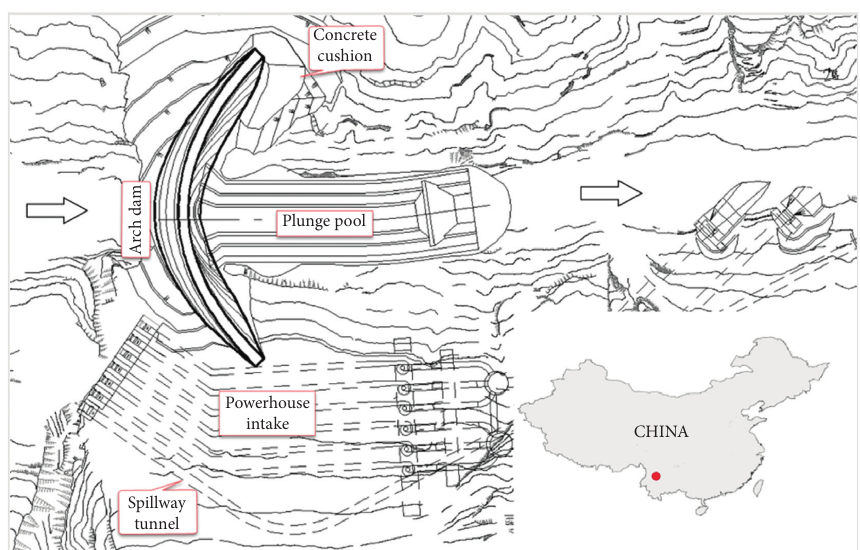
Figure 4: Layout chart of the high-arch dam.